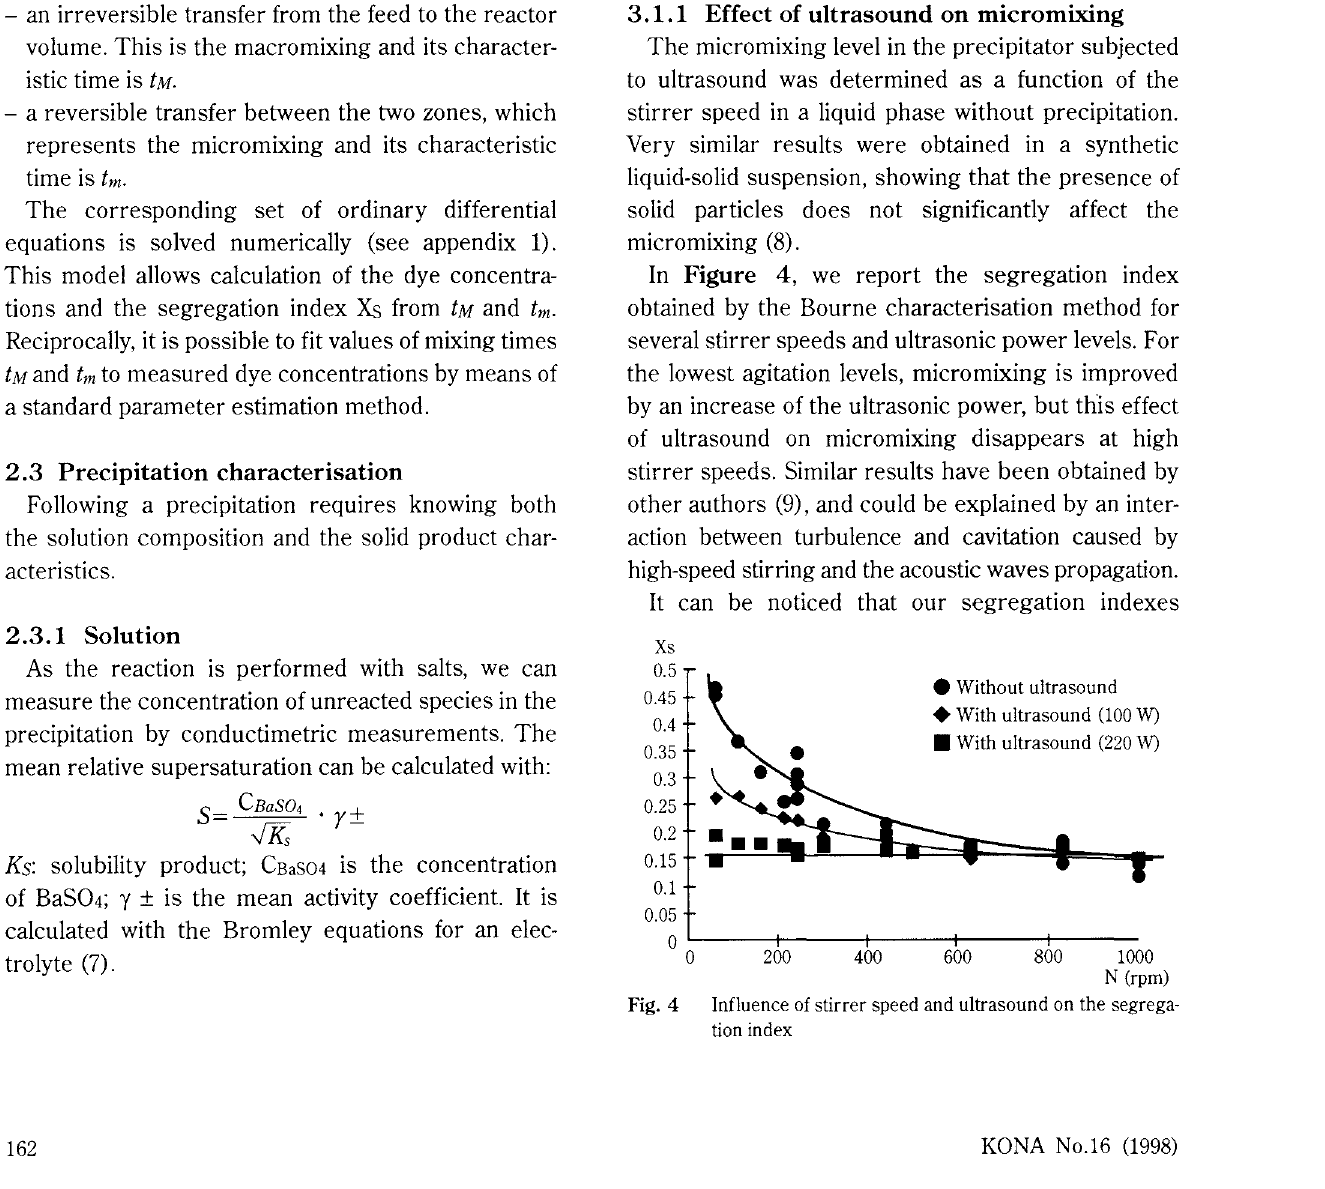
Fig. 3 Principle of SFM model for a simple jet reactor order to deduce the mixing times from the measured segregation